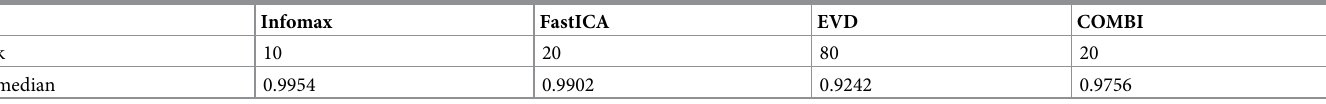
Table 4. ICASSO repetition number k with the highest median Iq of each algorithm (motor